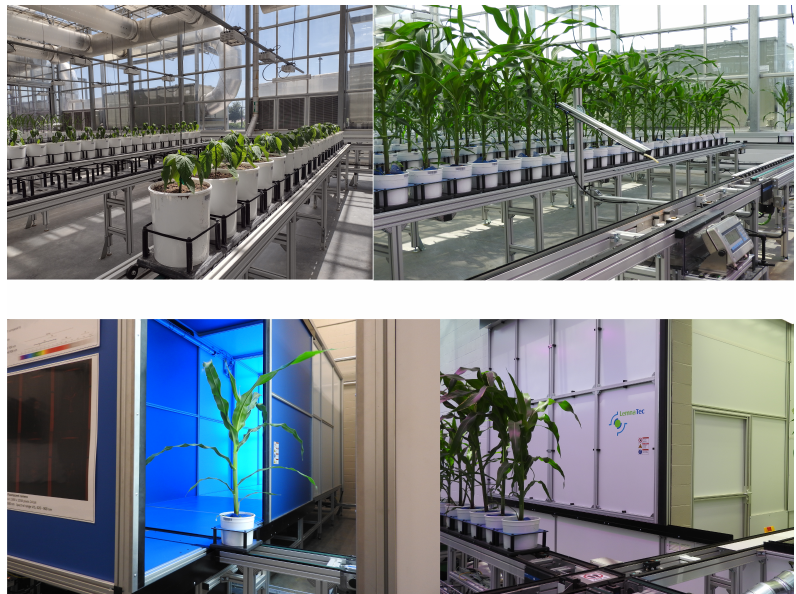
Figure 1. LemnaTec Scanalyzer 3D high-throughput plant phenotyping facility at the UNL: view of the automated greenhouse ( top-left ); watering station ( top-right ); a plant entering the fluorescent chamber ( bottom-left ); and plants on the conveyor belt heading towards the visible light chamber ( bottom-right